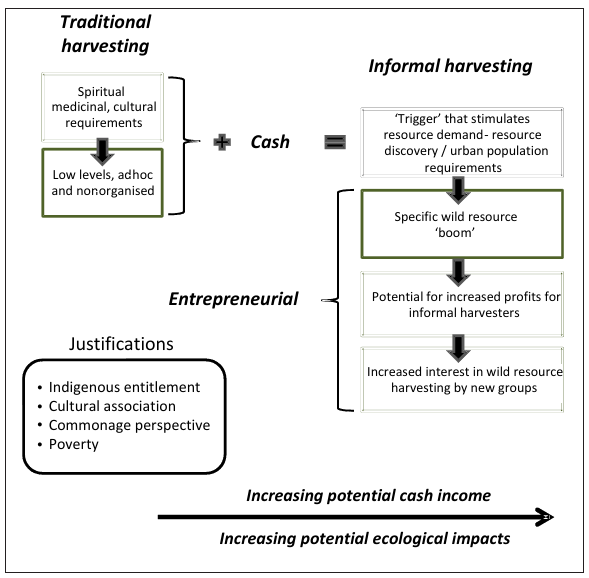
The evolution of illicit natural resource harvesting motivations in Cape Town